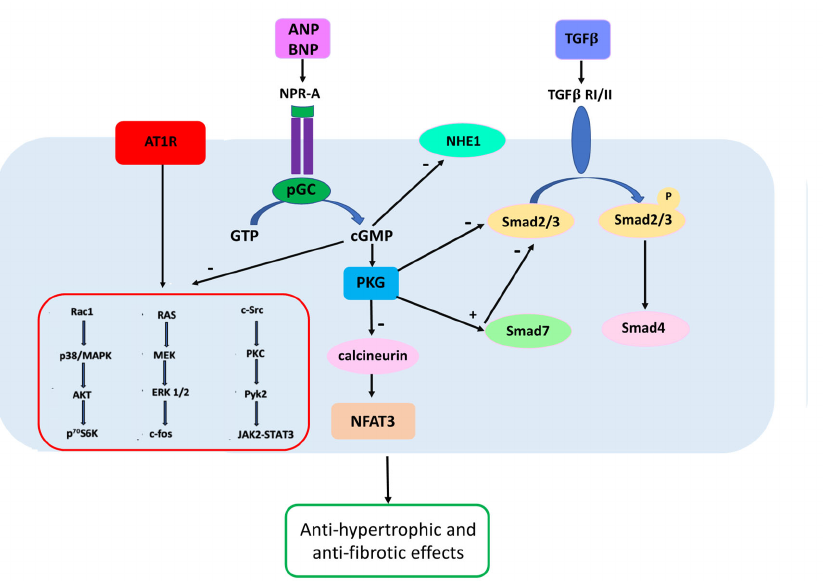
Figure 2. Anti ‐ hypertrophic and anti ‐ fibrotic effects of natriuretic peptides. Legend to Figure 2: ANPs and BNPs antagonize calcineurin/NFAT, NHE ‐ 1, TGF ‐β 1, and angiotensin II signaling. ANP, atrial natriuretic peptide; cGMP, cyclic guanosine monophosphate; ERK, extracellular ‐ signal ‐ regulated kinase; JAK, Janus kinase; JNK, c ‐ JUN N ‐ terminal kinase; MAPK, p38 mitogen ‐ activated protein kinase; MEK, mitogen ‐ activated protein kinase; NFAT, nuclear factor of activated T cells; NHE, Na+/H+ exchanger; NPR ‐ A, type A natriuretic peptide receptor; NP, natriuretic peptide; p 70 S6K, ribosomal protein S6 kinase beta ‐ 1; PKG, protein kinase G; PyK2, proline ‐ rich tyrosine kinase 2; Rac1, Ras ‐ related C3 botulinum toxin substrate; Smad, suppressor of mothers against decapentaplegic; STAT3 signal transducer and activator of transcription 3; TGF, tumor growth factor.